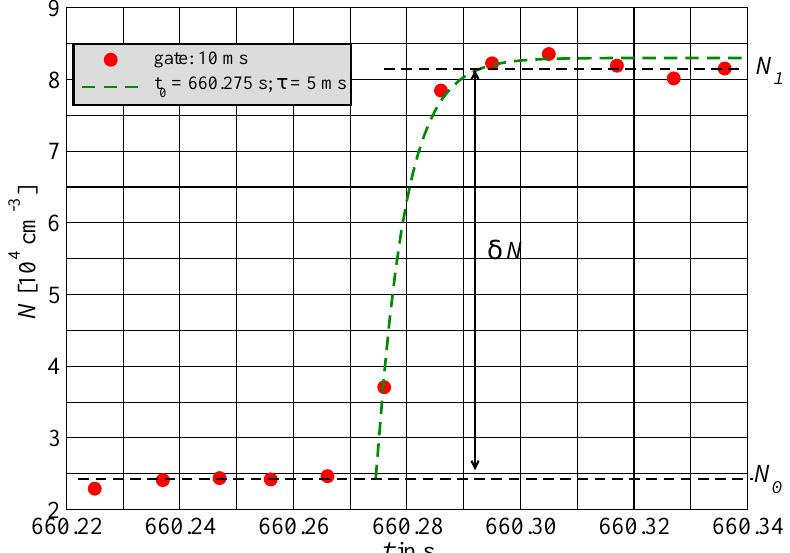
Fig. 9. A 120-ms long subrecord of the time series presented in Fig. 8 marked by the blue box is shown. The varying wind direction created strong fluctuations of N resulting in sharp ramps. Assuming a first-order response of the FCPC, the e-folding time τ can be estimated from such a ramp to τ ≈ 5ms.